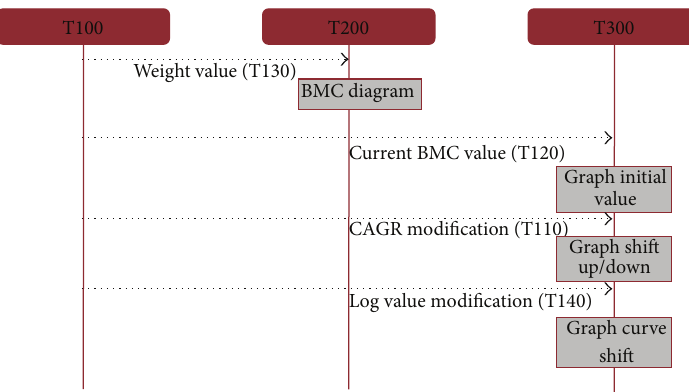
Figure 2: Parameter value effect diagram.